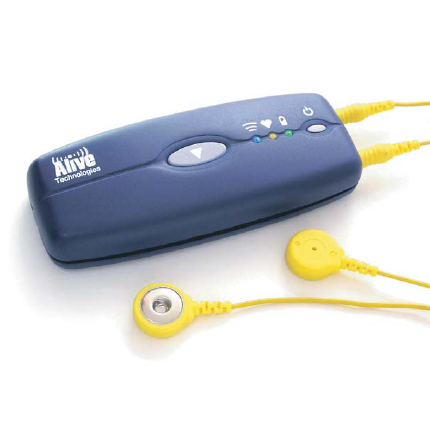
Figure 1. The sensor in our